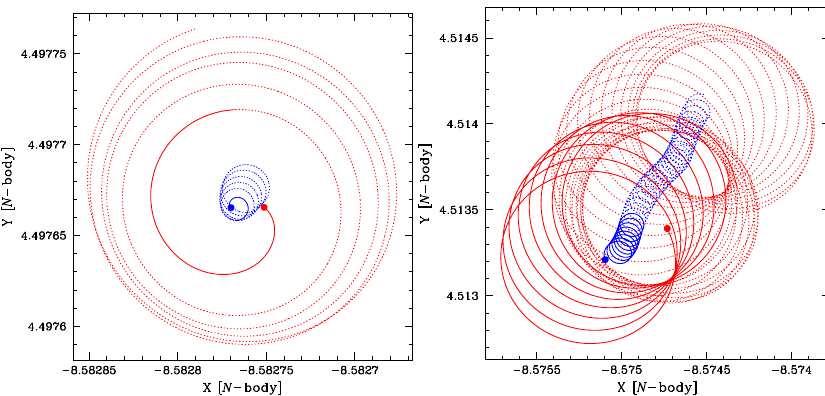
Fig. 65 Projection in the x–y plane of two moments in the orbital evolution of a binary. The length units are given in N -body units For this example, the binary has a mass ratio of 10, and is integrated with N -body6 including the post-Newtonian treatment described in Kupi et al. (2006). The expressions corresponding to the relativistic corrections for the accelerations and their time derivatives are given in Eqs. (187)–(193). For this particular simulation, I did an N -body unit of length corresponds to 0 . 21 pc (see Sect.